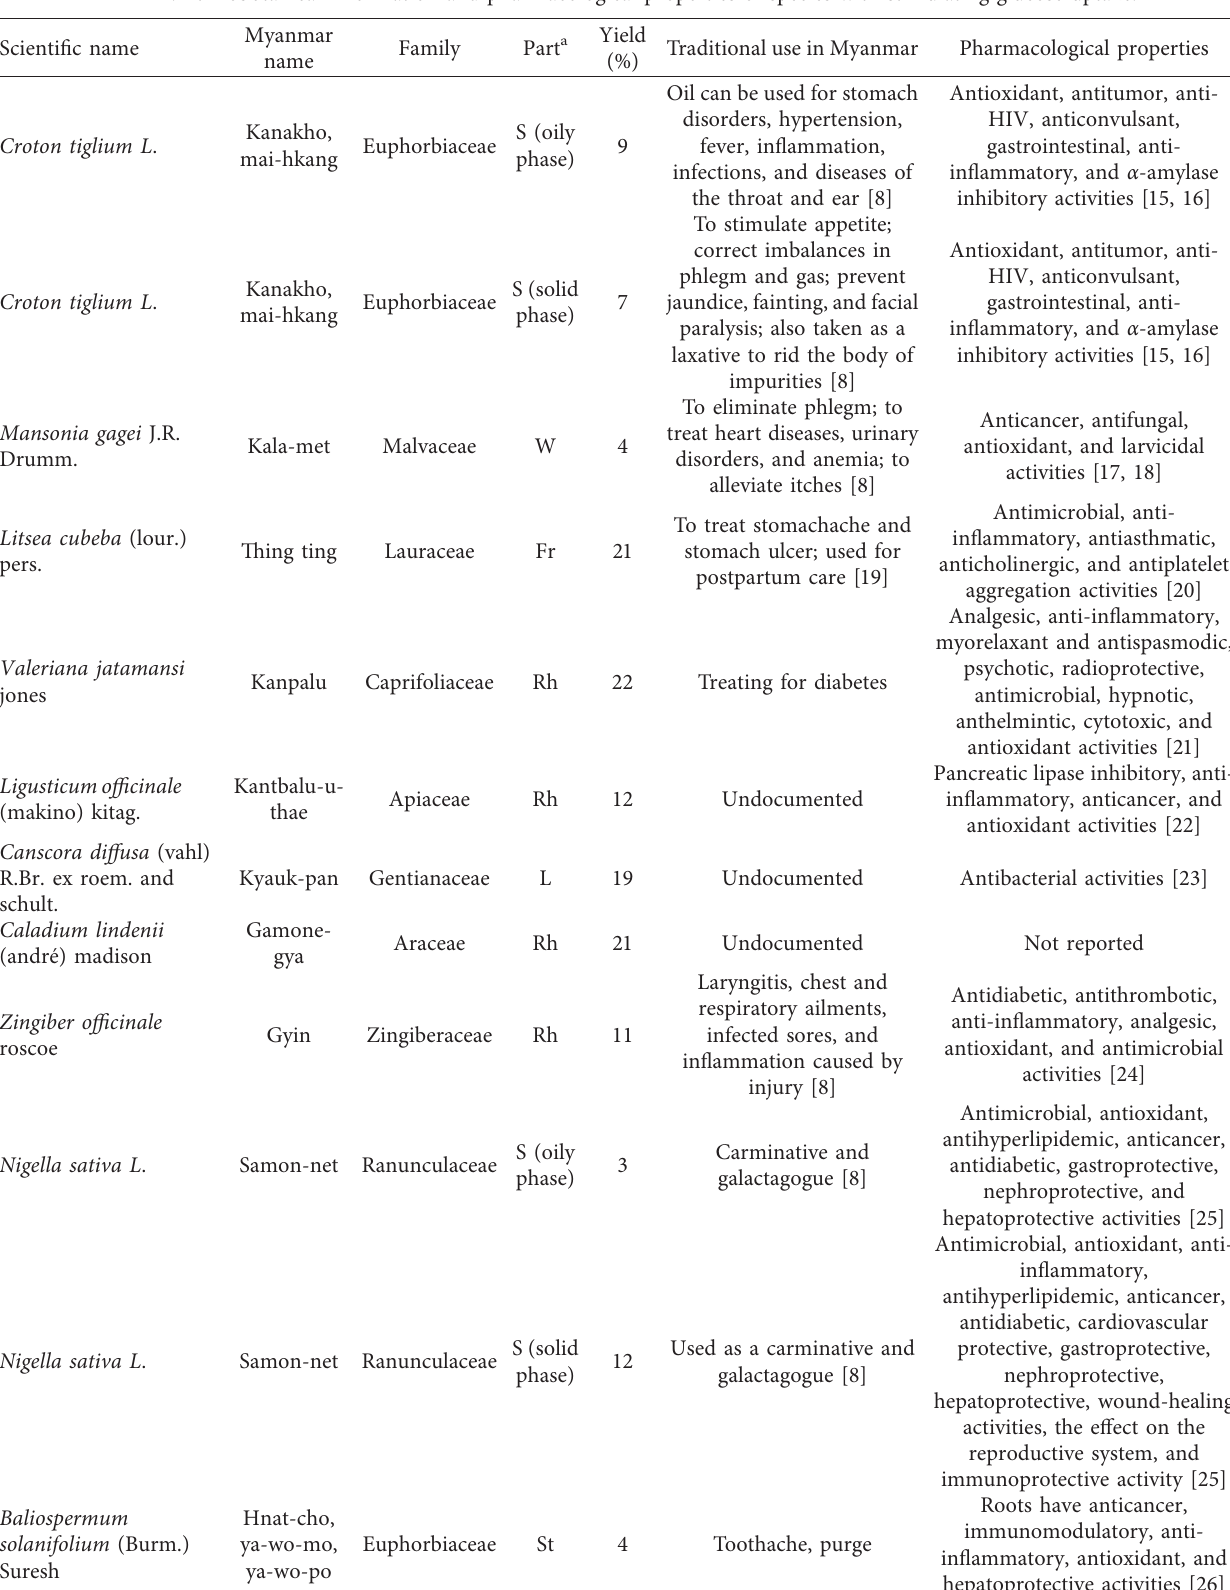
Table 2: Ethnobotanical information and pharmacological properties of species with stimulating glucose